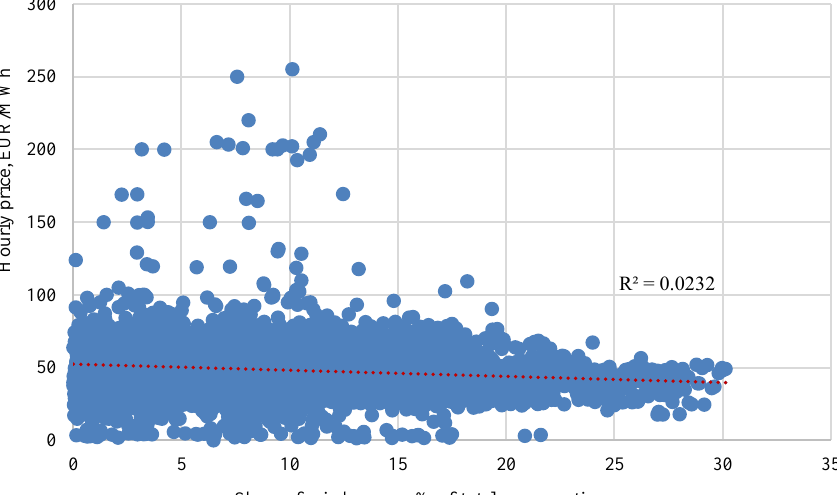
Fig. 4. Correlation between average power market price and share of wind power in the total consumption (demand) in Baltic countries during 2019 (Data source: Nord Pool Spot).